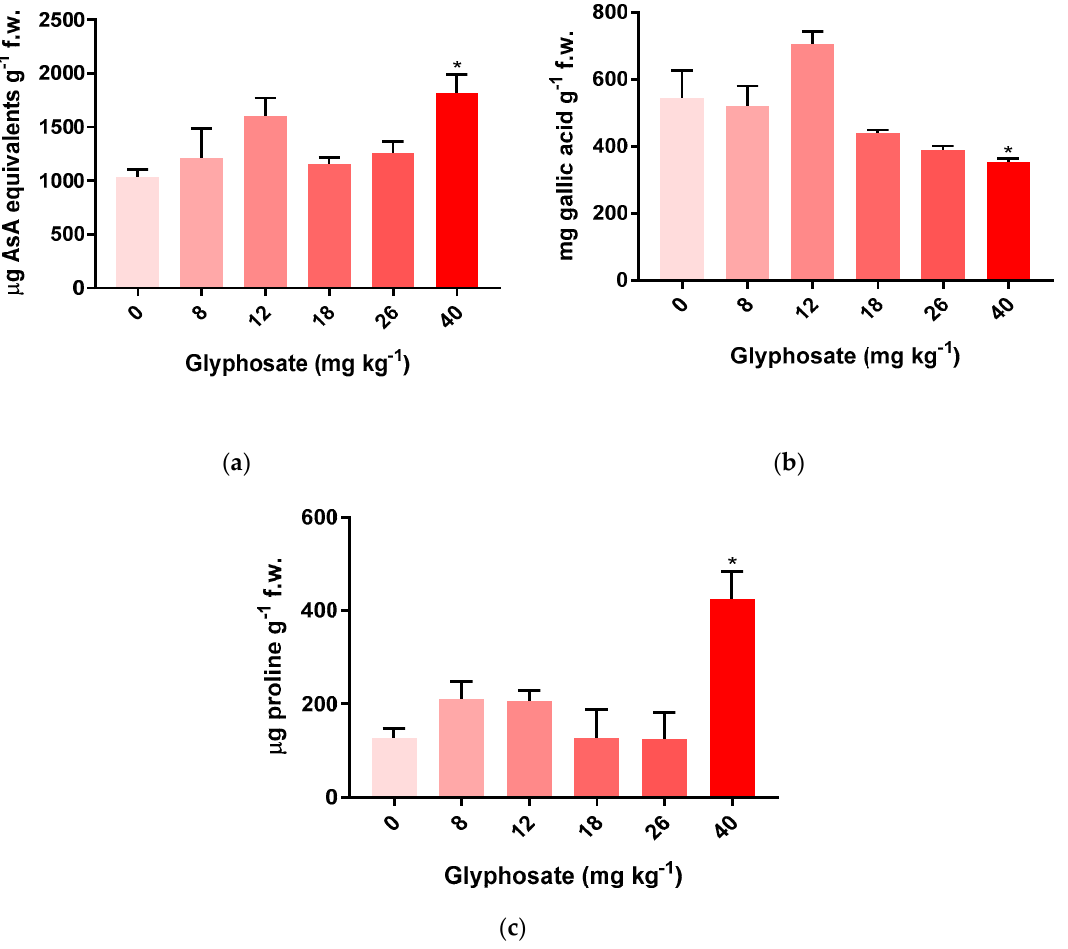
Figure 5. Effect of increased concentrations of GLY, on the AOX (antioxidant) system of M. sativa shoots after 21 days of exposure. ( a ) Total antioxidant capacity (TAC); ( b ) Total phenol content (TPC); ( c ) Proline (Pro). Error bars correspond to the standard deviation. Statistically significant differences compared to the CTL, considering p ≤ 0.05, are marked with a * above bars.